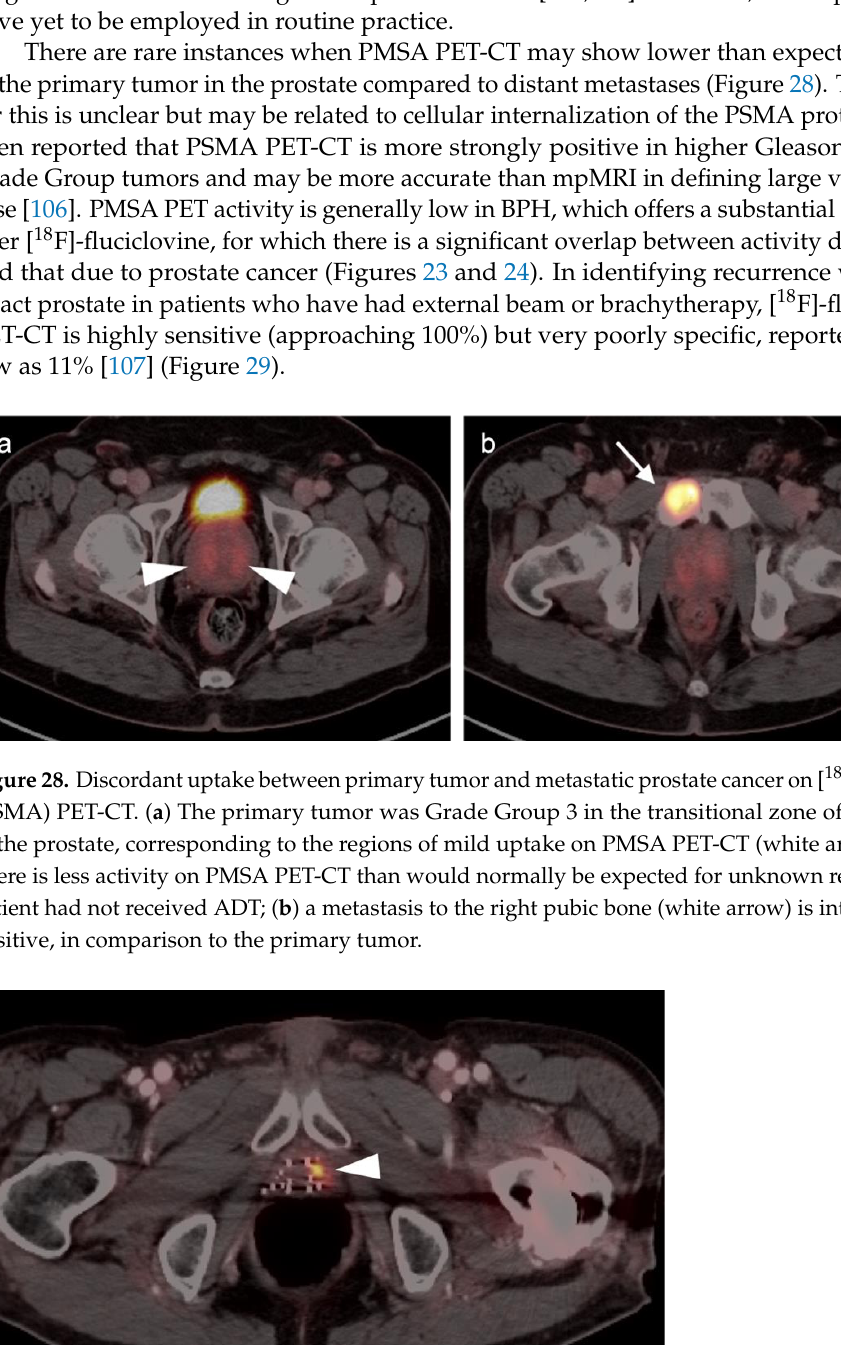
Figure 27. Diagnostic value of PSMA PET-CT detecting extra-prostatic recurrence in the face of metal artifact. ( a , b ) There is prostate cancer recurrence in the right seminal vesicle (white arrows), identified despite the presence of bilateral total hip prostheses. A metal artifact reduction algorithm was utilized for the CT; ( c ) Multiple brachytherapy seeds are present (white arrowheads) without obvious recurrence within the prostate.